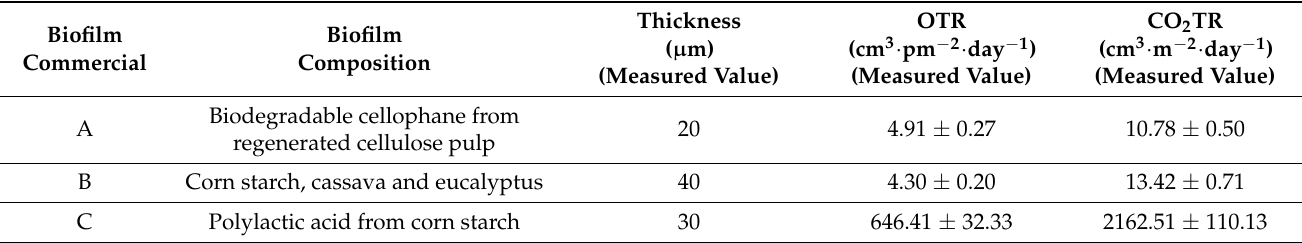
Table 1. Composition of commercial biofilms, as reported on the package label, and measured thickness, oxygen transmission rate (OTR) and carbon dioxide transmission rate (CO 2 TR).